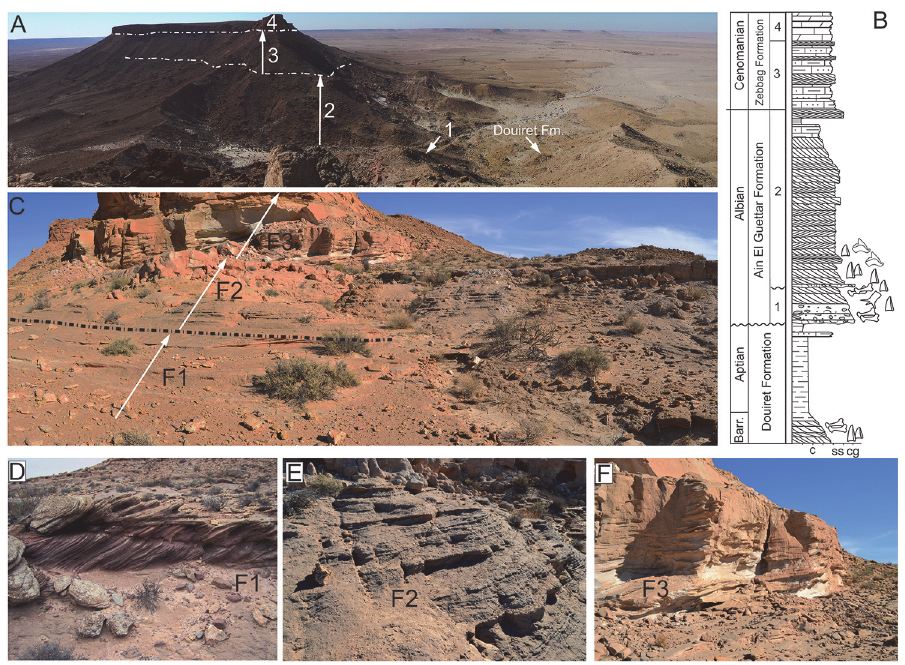
Fig 2. Stratigraphy at the El Mra locality. A, panoramic view of the El Mra mesa-like morphology. 1. Chenini Mbr., 2. Oum Ed Diab Mbr., 3. Keker Mbr., 4. Gattar Mbr. B, simplified field-log of the El Mra section showing the stratigraphic occurrence of vertebrate and plant remains. C, facies distribution in the Chenini-Oum Ed Diab transition. F1, high-energy, fluvial sandy bar deposits; F2, low-angle shoreface deposits; F3, fine- grained tidal deposits with flaser-like structures. D, E, F, field photographs of the different deposits exposed at the El Mra locality. T . hannibalis was recovered from the F1 beds.